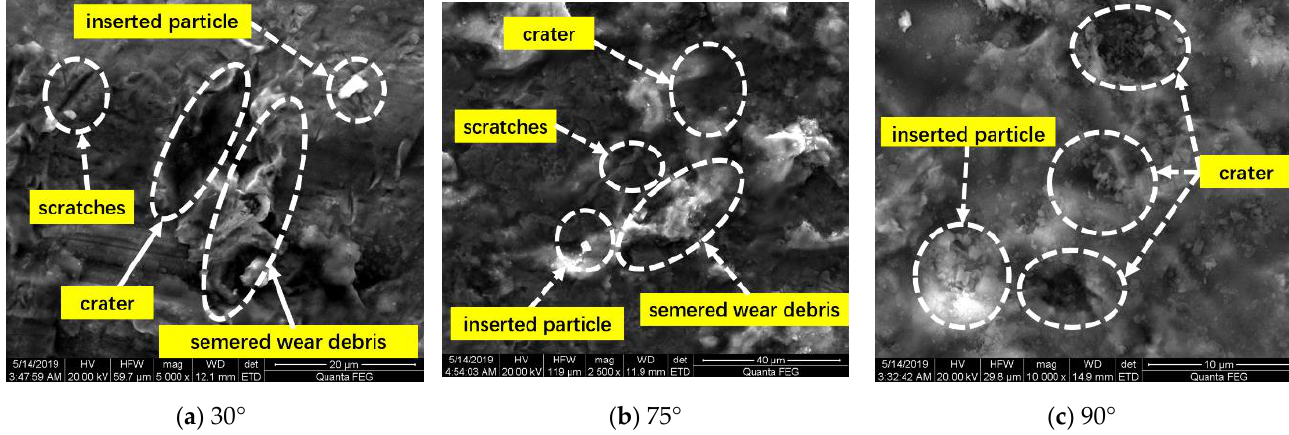
Figure 4. SEM images of samples at different impact angles. ( a ) 30° impact specimen appearance. ( b ) 75° impact specimen appearance. ( c ) 90° impact specimen appearance.